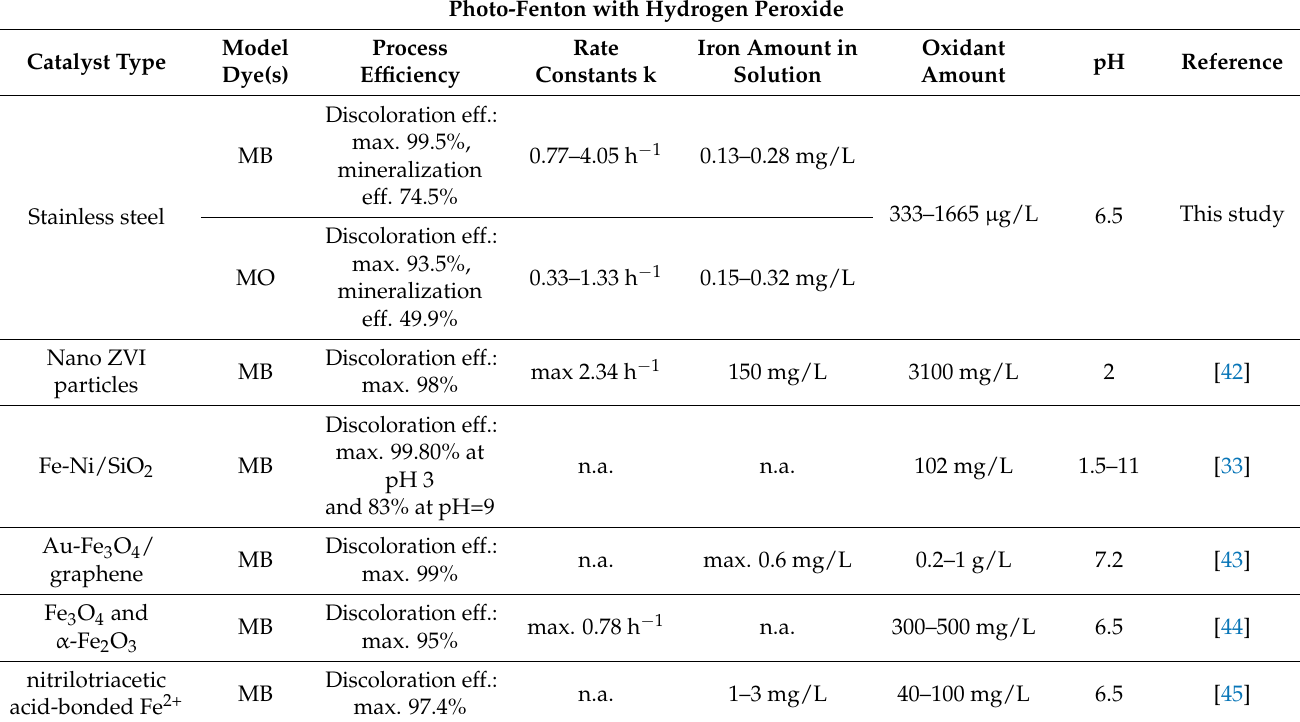
Table 3. Parameters of selected photo-Fenton processes from the reference literature compared to those of the present